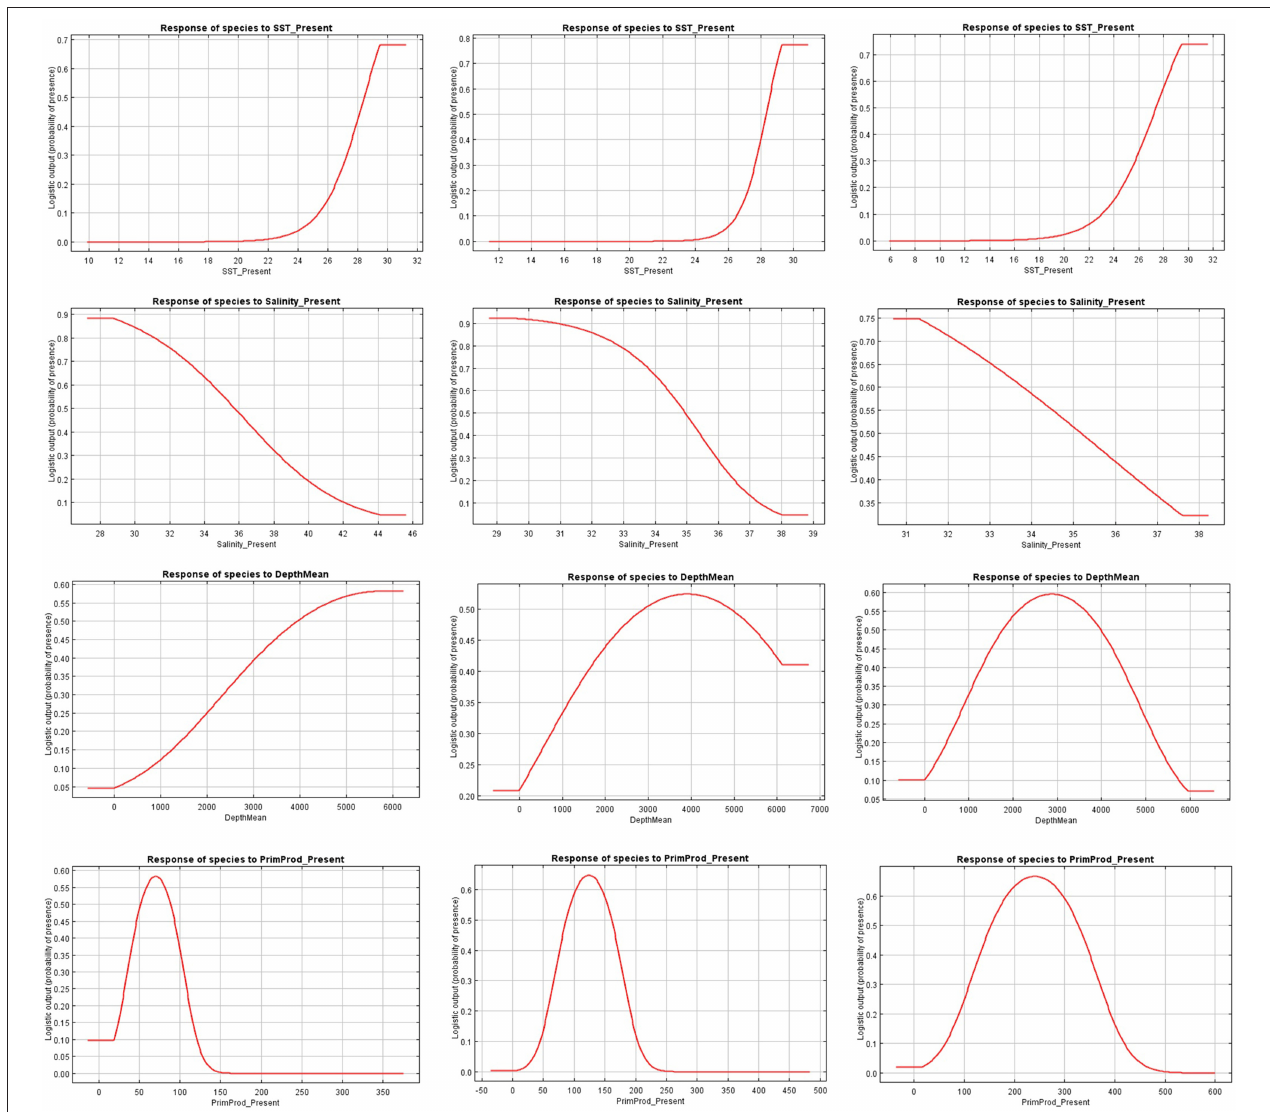
FIGURE 4 | Present response curves (sea surface temperature, salinity, depth, and primary production) for Canthidermis maculata in the Indian (first column), Atlantic (second column), and Eastern Pacific Ocean (third